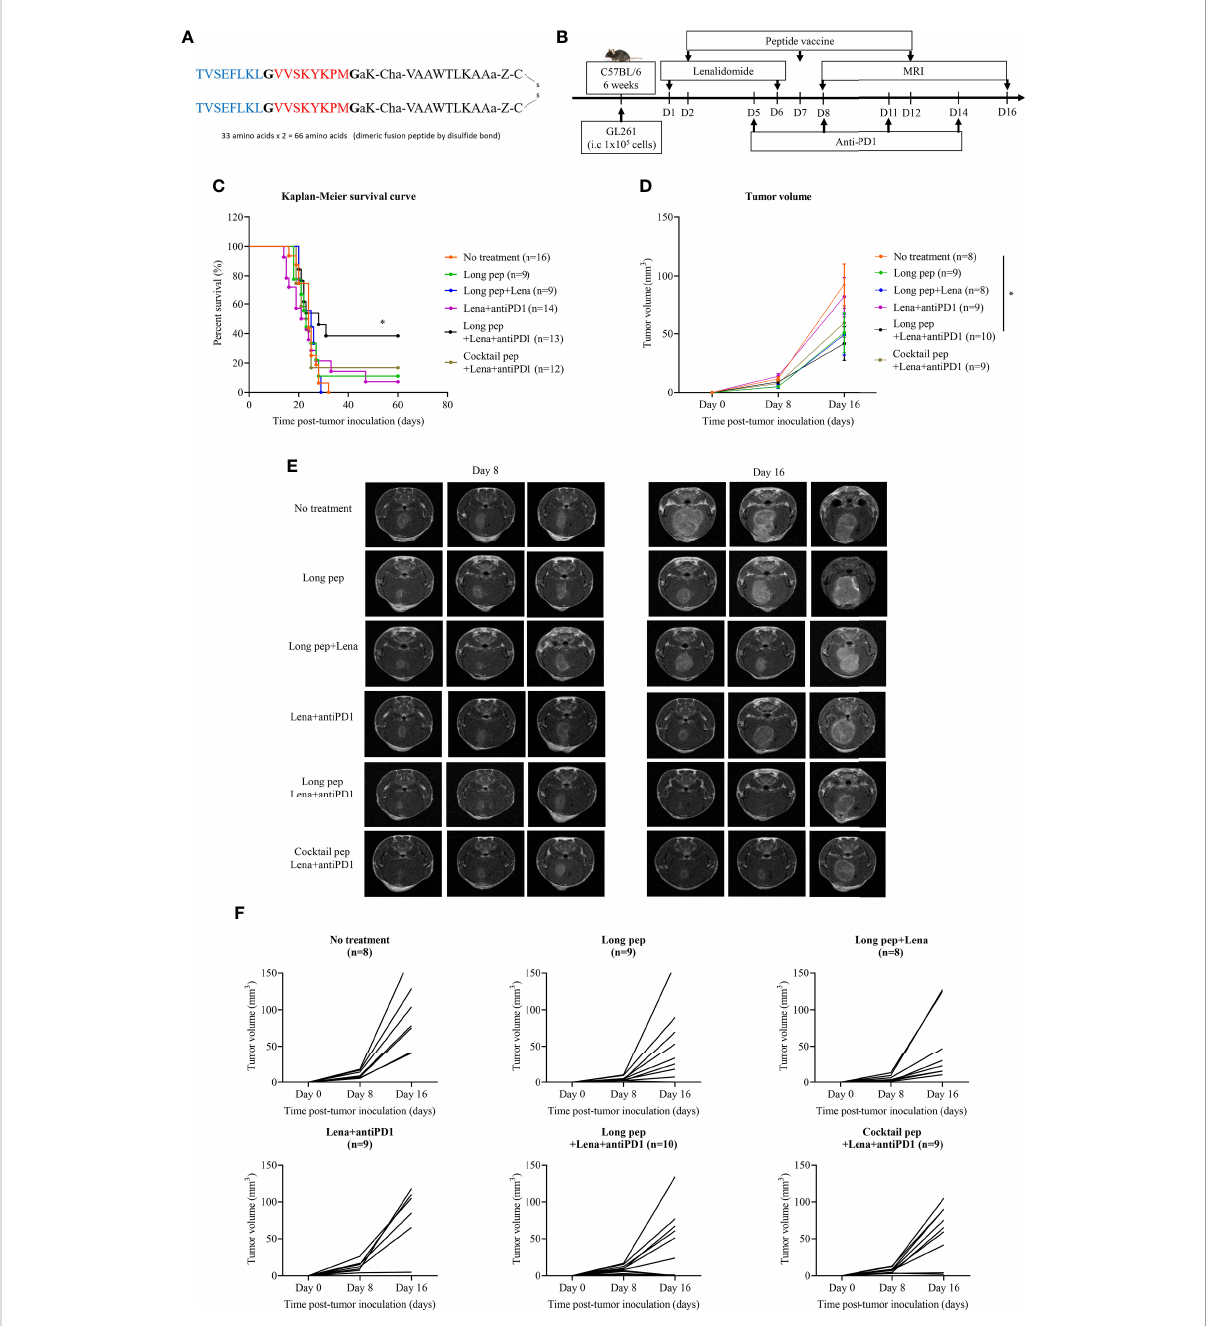
FIGURE 1 The construction of the long multi-epitope peptide vaccine (A) . Schema outlining treatments used in this experiment (B) . The therapeutic effects of the peptide vaccine combined with lenalidomide and anti-PD1 was clari fi ed. Kaplan-Meier survival curves were used to determine the survival of the mouse tumor model according to the different combination treatments in GL261 glioma-bearing mice (No treatment: n = 16, long pep: n = 9, long pep+Lena: n = 9, Lena+anti-PD1: n = 14, long pep+Lena+anti-PD1: n = 13, and cocktail pep+Lena+anti-PD1: n = 12) (C) . Brain tumor sizes after treatment with the different combinations were con fi rmed using magnetic resonance imaging (MRI) (No treatment: n = 8, long pep: n = 9, long pep+Lena: n = 8, Lena+anti-PD1: n = 9, long pep+Lena+anti-PD1: n = 10, and cocktail pep+ Lena+anti-PD1: n = 9). The tumor volume was calculated by summating all tumor areas in each slide and multiplying by the slice thickness. The data is presented in the line graph. Data is shown as the mean ± standard error of the mean (SEM) (D-F) . No treatment: no treatment group; Long pep: long multi-epitope peptide; Long pep+Lena: long multi-epitope peptide plus lenalidomide; Lena+anti-PD1: Lenalidomide plus anti-PD1; Long pep+Lena+anti-PD1: long multi-epitope peptide plus lenalidomide and anti-PD1; Cocktail pep+Lena+anti-PD1: cocktail of multi-epitope peptide plus lenalidomide and anti-PD1. P< 0.05